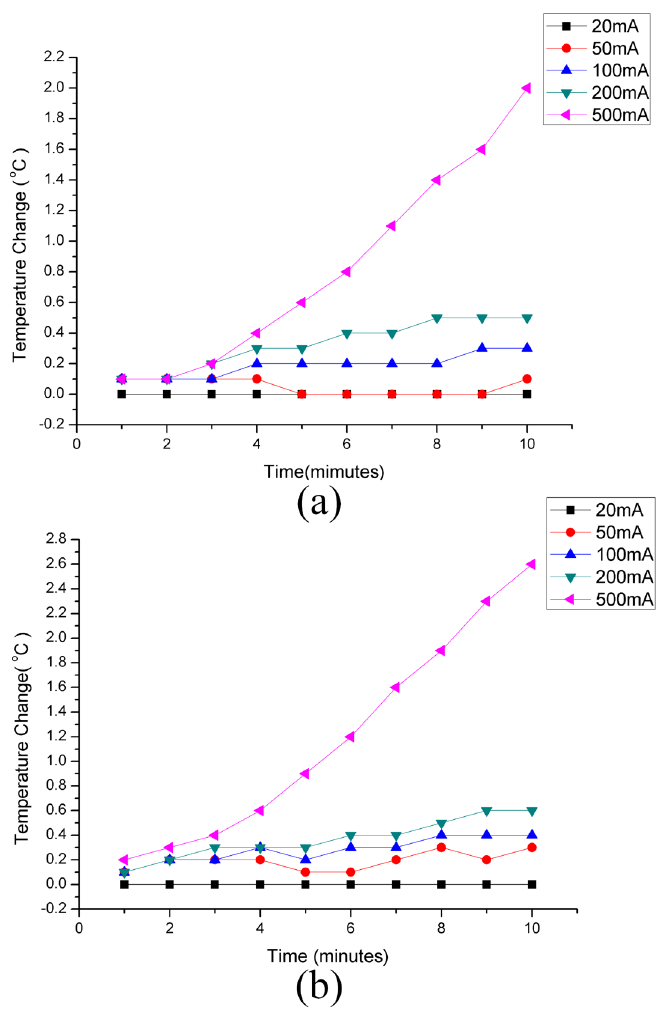
Figure 9. The temperature changes of two needles under different recharging current levels with base a temperature of 26.8 °C. ( a ) The temperature changes of Needle one. ( b ) The temperature changes of Needle